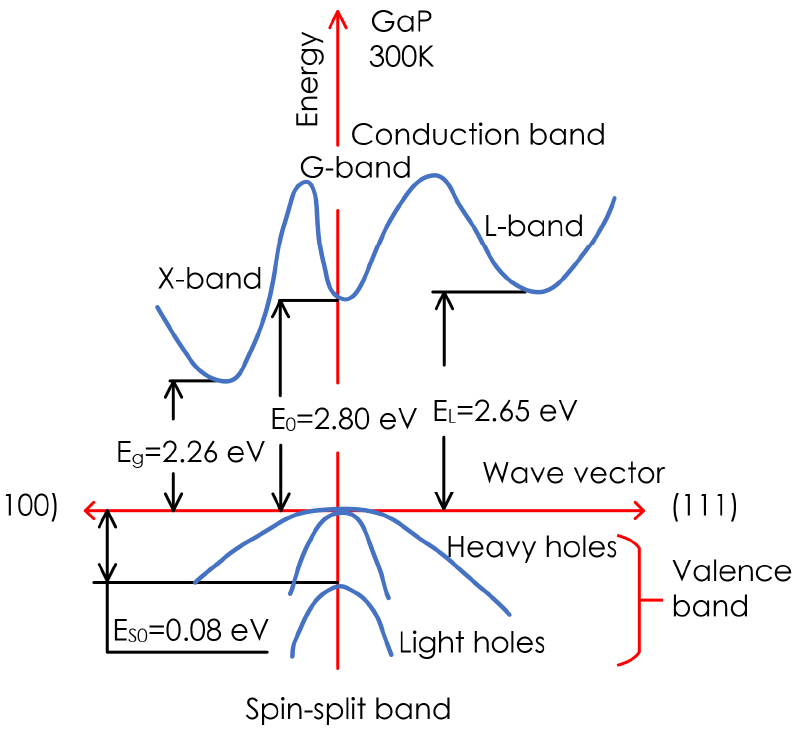
Figure 8. Scheme of optical transitions in the gallium phosphide band structure. E g , E 0 , and E L are energies of optical transitions determined from the photocurrent spectrum of SBs.